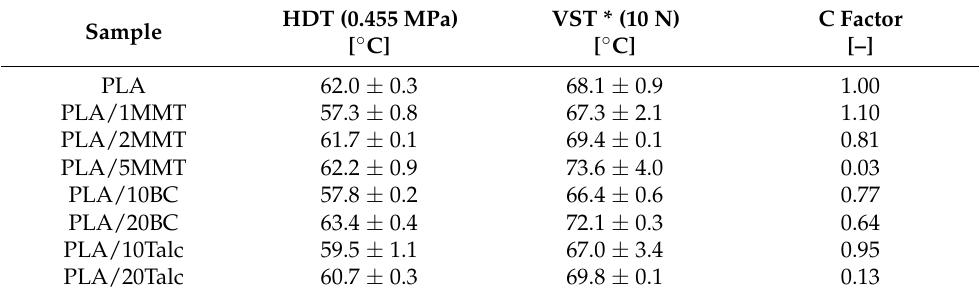
Table 3. The results of heat deflection temperature (HDT), Vicat softening point (VST) measurements, and C-factor